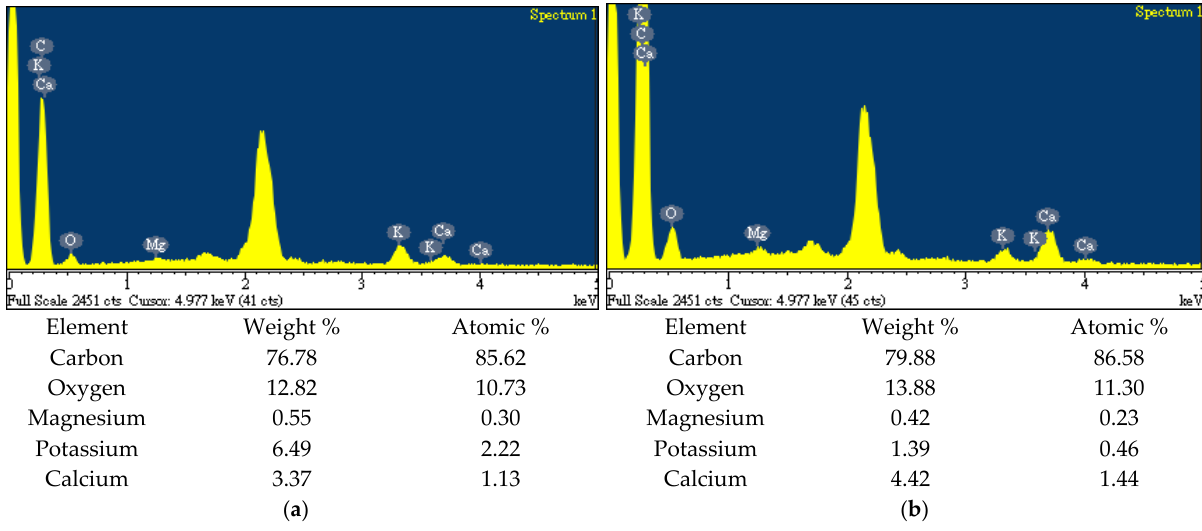
Figure 7. EDS spectra of the biochar products for ( a ) SMC-SF-BC-800 and ( b ) SMC-BF-BC-800.